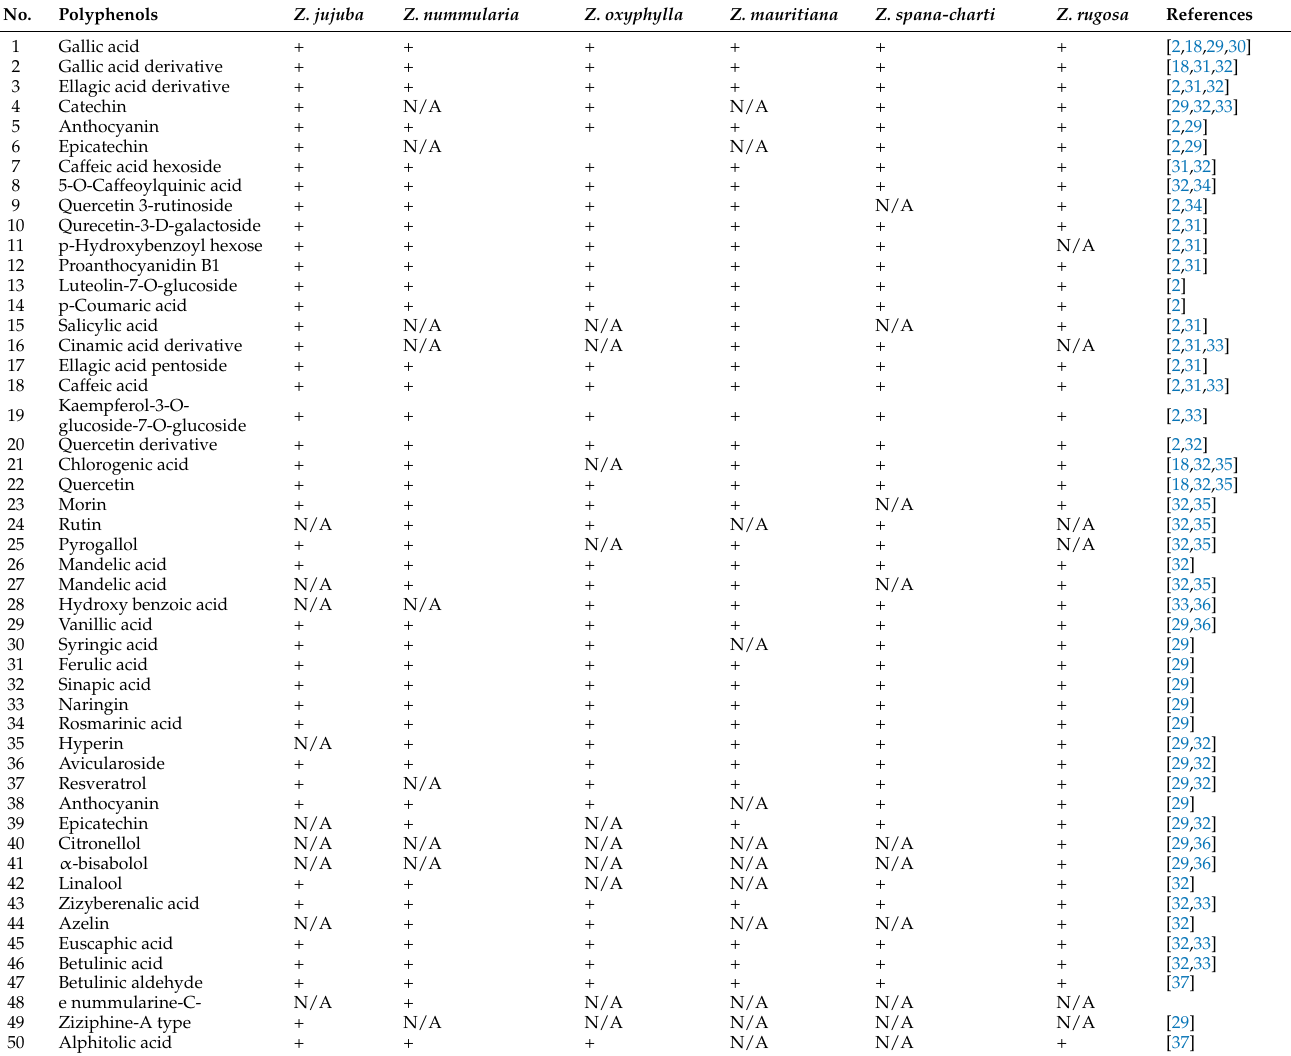
Table 1. Different isolated phenolic compounds from previous studies of Ziziphus